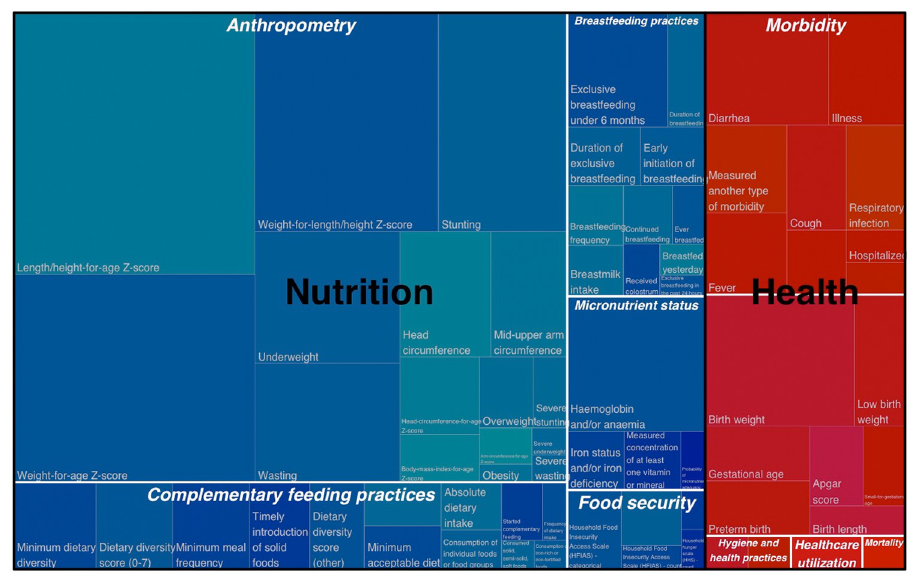
Fig 4. Treemap of constructs and indicators hierarchically organized for nutrition and health components of nurturing care. Each rectangle represents a unique indicator that is nested in terms of three levels: nurturing care component (e.g., nutrition), construct (e.g., anthropometry), and indicator (e.g., length/height-for-age z-score). The size, location, and color of the rectangle is proportional to number of unique studies and the hierarchical structure.